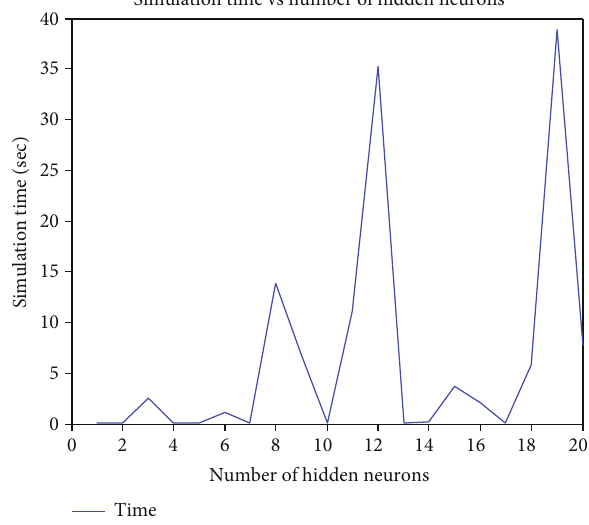
Figure 16: Five input MLPNN-based forecasting model simulation times vs. the number of hidden